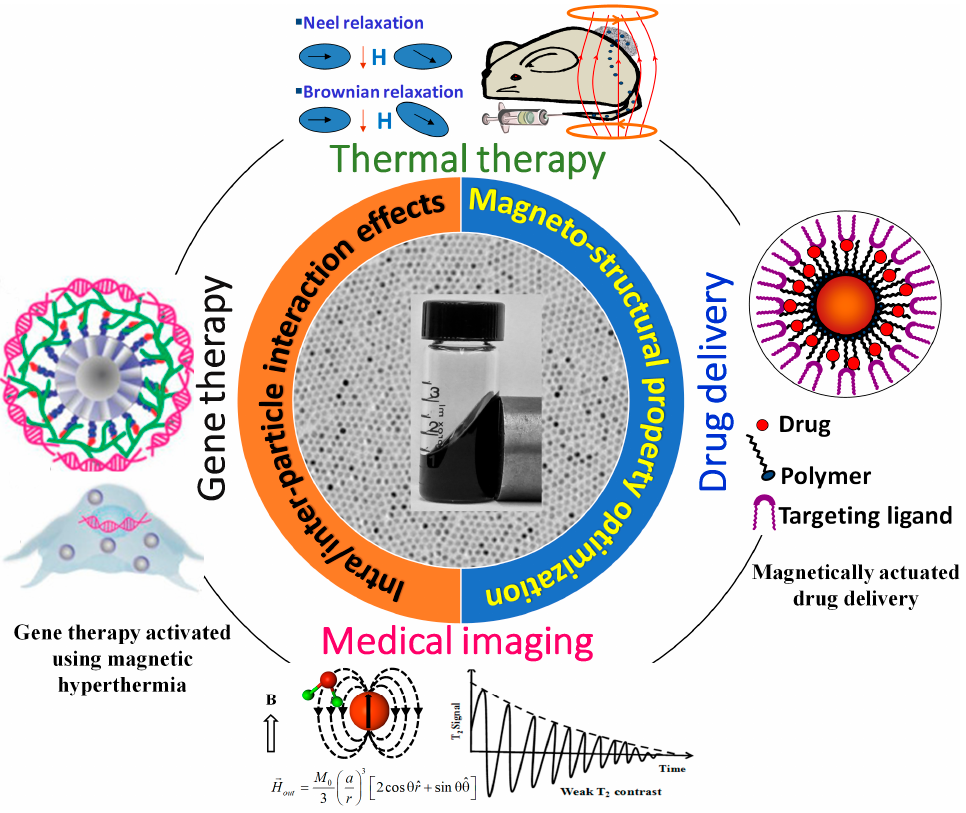
Figure 1. Based on the heat activation ability, these nanostructures have been utilized in cancer therapy, on-demand drug carrier and gene therapy applications [32,33]. The magnetic nanoparticles have also been as contrast agent in magnetic particle imaging (MPI) and magnetic resonance imaging (MRI).